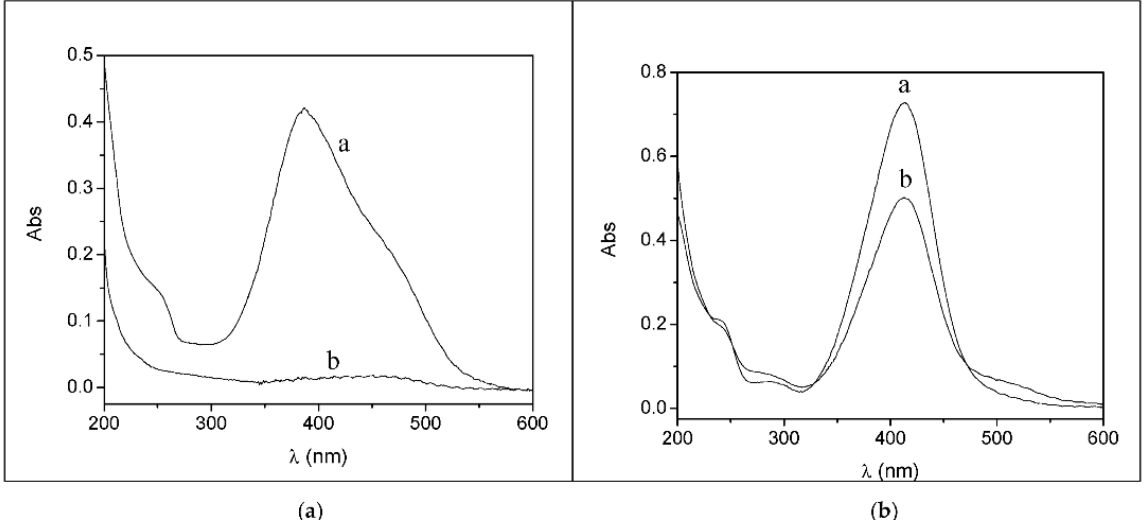
Figure 6. Ultrafiltration experiments on the PAR/SDS system: ( a ) absorption spectra of PAR (2.2 × 10 − 5 M) in water (line a) and of the permeate obtained after ultrafiltration in 0.040 M SDS (line b) at pH 3.2; ( b ) absorption spectra of PAR (2.2 × 10 − 5 M) in water (line a) and of the permeate obtained after ultrafiltration in 0.040 M SDS (line b) at pH 8. Figure adapted with permission from reference [77]. Copyright 2008 American Chemical Society.